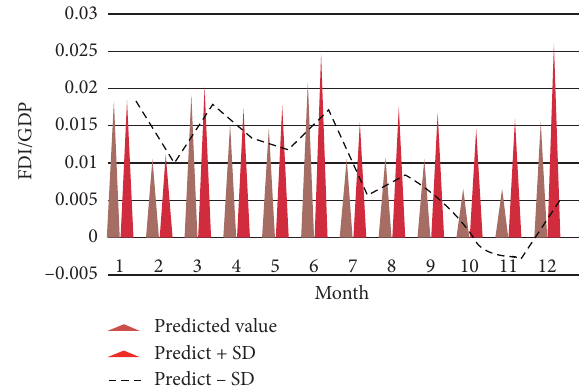
Figure 7: 2020 FDI/GDP forecast data.